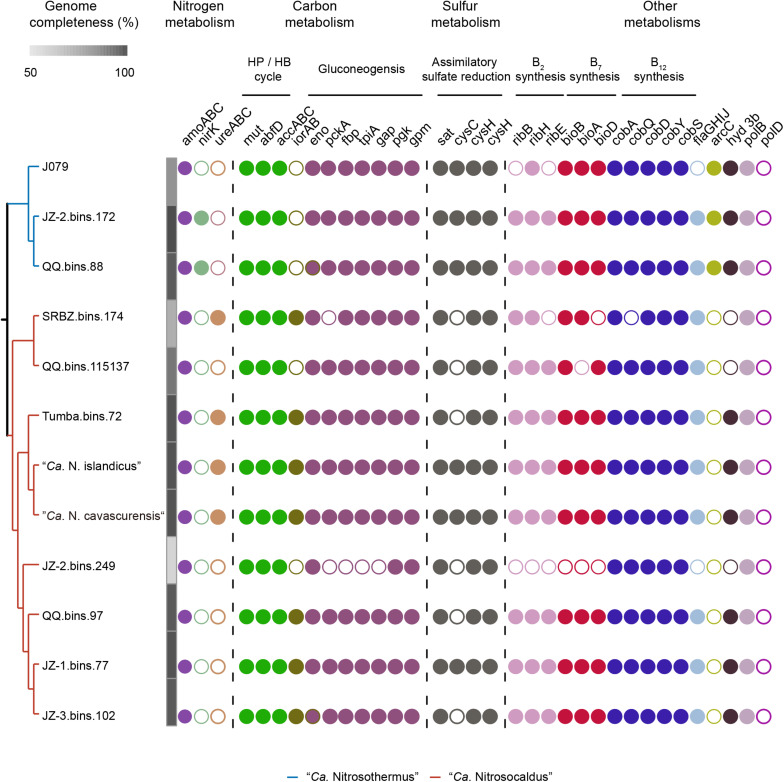
The overall distributions of the genes of interest in “Ca. Nitrosocaldaceae.” The phylogenetic tree in the left was pruned according to Figure 1. For visualization, the branch length is ignored. The two genera were colored according to Figure 1. MAGs of “Ca. Nitrosothermus” are marked with blue while MAGs of “Ca. Nitrosocaldus” with red. The solid and hollow circles represent the presence and absence of the genes. J079 Thaumarchaeota archaeon J079, HP/HB cycle hydroxypropionate/hydroxybutyrate cycle, amoABC ammonia monooxygenase subunit A, B, and C, nirK nitrite reductase, ureABC urease subunit gamma, beta and alpha, mut cobalamin-dependent methylmalonyl-CoA mutase, abfD 4-hydroxybutyryl-CoA dehydratase, accABC biotin-dependent acetyl-CoA/propionyl-CoA carboxylase, iorAB indolepyruvate ferredoxin oxidoreductase subunit alpha and beta, pckA phosphoenolpyruvate carboxykinase, fbp fructose 1,6-bisphosphate aldolase/phosphatase, tpiA triosephosphate isomerase, gap, glyceraldehyde-3-phosphate dehydrogenase, pgk phosphoglycerate kinase, gpm phosphoglycerate mutase, eno enolase, sat sulfate adenylyltransferase, cysC adenylylsulfate kinase, cysH phosphoadenosine phosphosulfate reductase, sir sulfite reductase (ferredoxin), flaGHIJ archaeal flagellar protein FlaG, FlaH, FlaI, and FlaH, arcC carbamate kinase, hyd 3b group 3b hydrogenase, polB archaea type DNA polymerase, polD D-family polymerase. The full name of genes involved in B2 (riboflavin), B7 (biotin), and B12 (cobalamin) syntheses are listed in Supplementary Table S4.